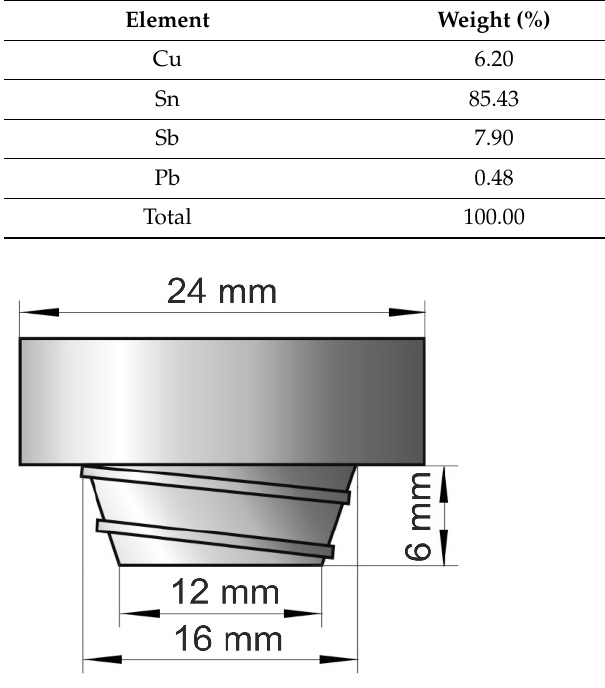
(Hitachi SU 70, Tokyo, Japan). The hardness was determined by the Brinell method with an